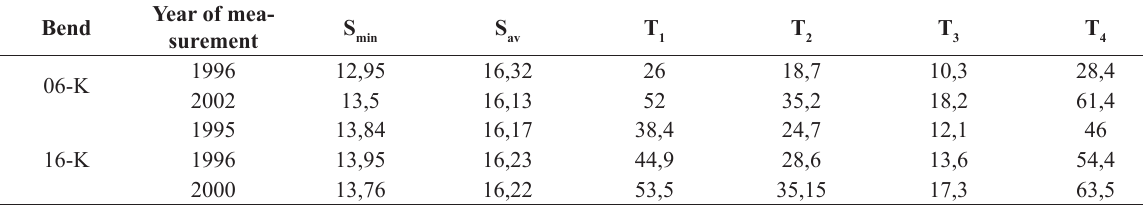
Table 11. Residual lifetime for bends (summary of results). Bend